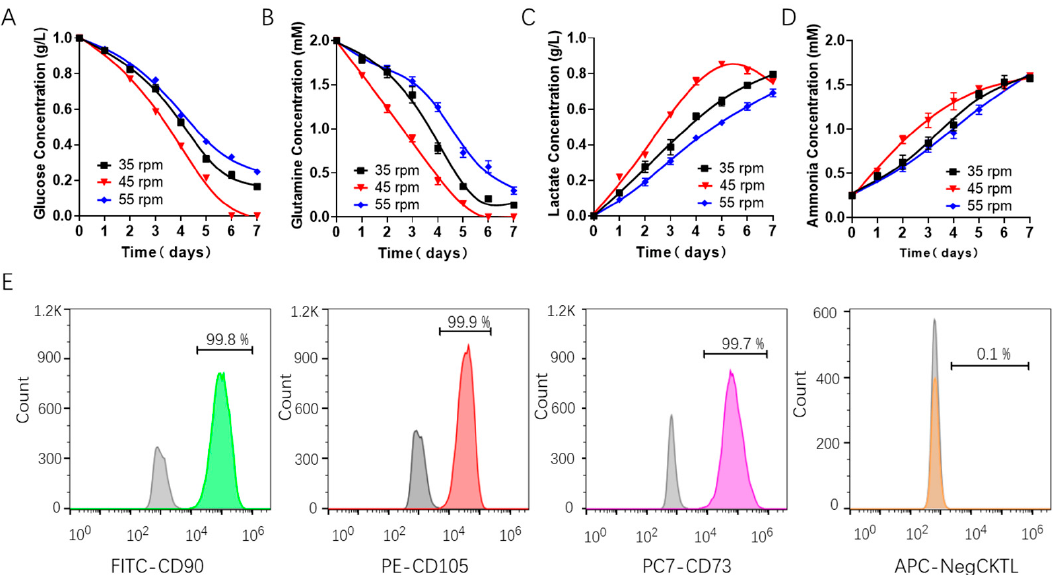
Figure 2. Cell metabolism characterization of batch-cultured hUCMSCs in 200 mL spinner flask. metabolite concentration assessment in the medium, including ( A ) glucose, ( B ) glutamine, ( C ) lactate and ( D ) ammonia. ( E ) Characterization of the hUCMSCs surface markers by flow cytometry using positive markers (FITC CD90, PE CD105 and CD73) and negative ones (APC CD14, CD19, CD34, CD45 and HLA-DR), where the gray and colored peak respectively represent the control and experimental group.